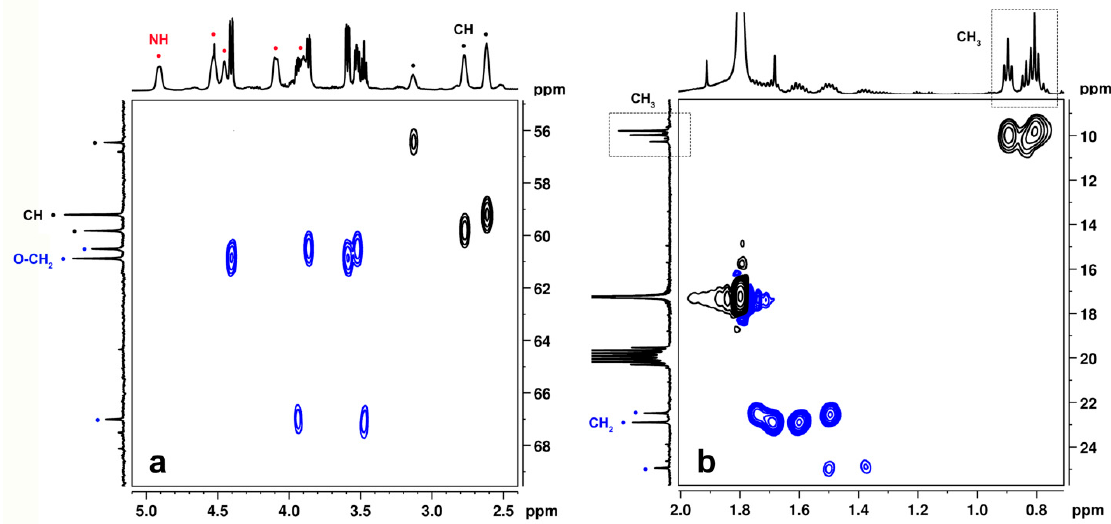
Figure 4. 1 H- 13 C HSQC NMR spectrum of 2 M mixture of ligand 2c and BH 3 •SMe 2 in toluene-d 8 . The correlation peaks originating from the three sets of 2-aminobutanol-based structural fragments are indicated as follows: ( a ) the OCH 2 groups (blue dots) and the CH(NH 2 ) groups (black dots), and ( b ) the CH 2 groups (blue dots) and CH 3 groups enclosed in the dashed rectangle. The six protons from the three NH 2 groups (red dots) were identified due to a lack of cross-peaks with C-atoms over one bond.